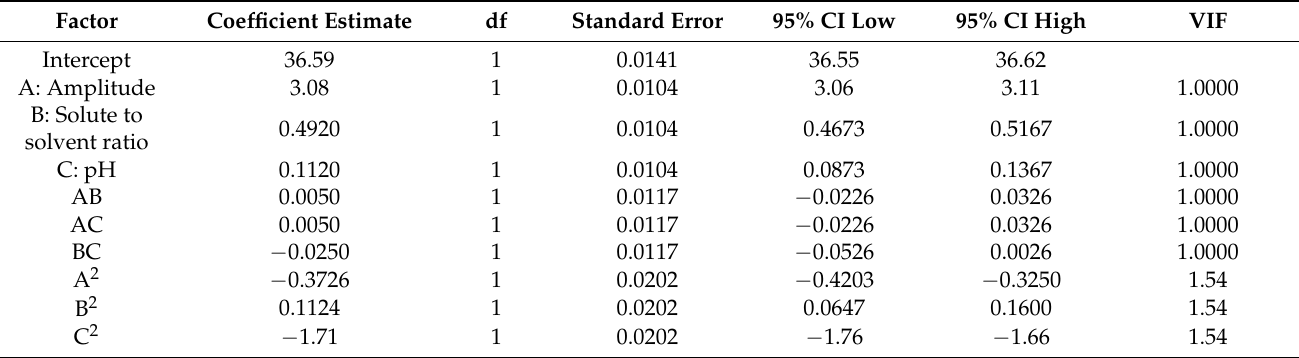
Table 3. Coefficient estimation in terms of coded factors.